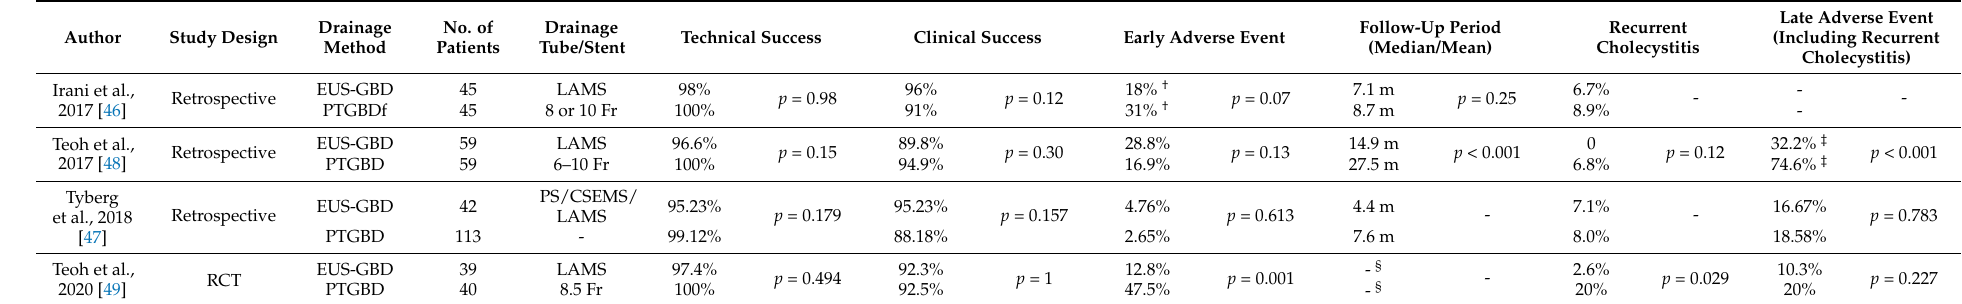
Table 2. Studies comparing long-term outcomes of endoscopic ultrasound-guided gallbladder drainage and percutaneous